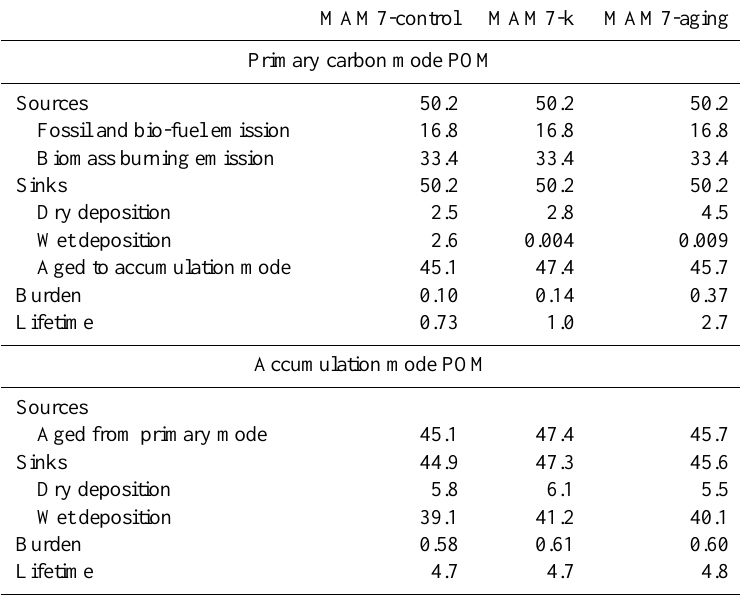
Table 11. Global budgets for primary carbon mode and accumulation mode POM from the standard MAM7 simulation (MAM7-control) and the MAM-k and MAM-aging sensitivity experiments.